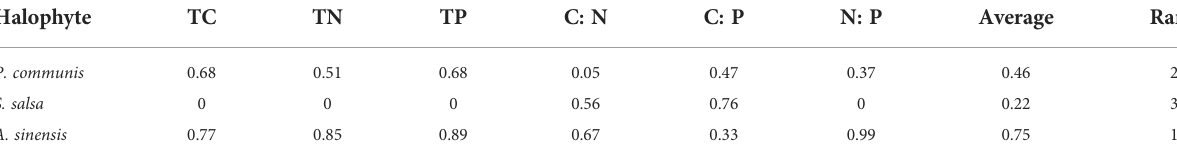
TABLE 3 Fuzzy mathematics subordinate value and homeostasis evaluation of three halophytes.